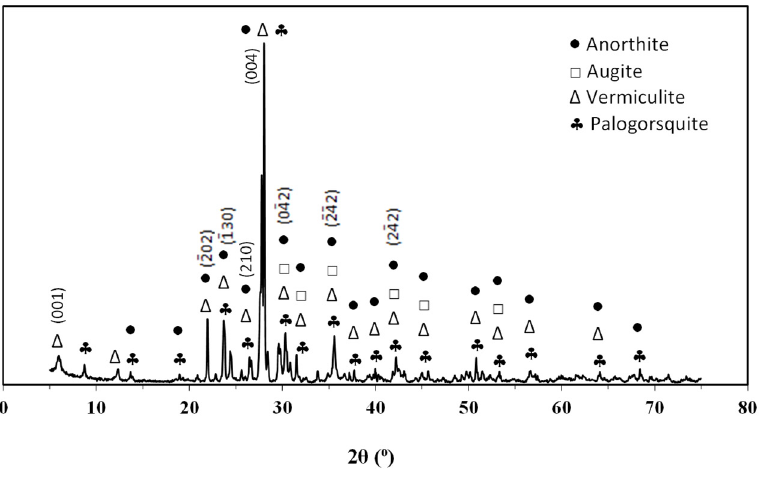
Figure 3. XRD patterns of basalt.